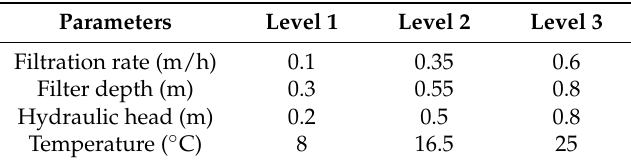
Table 2. The factorial experiment design.